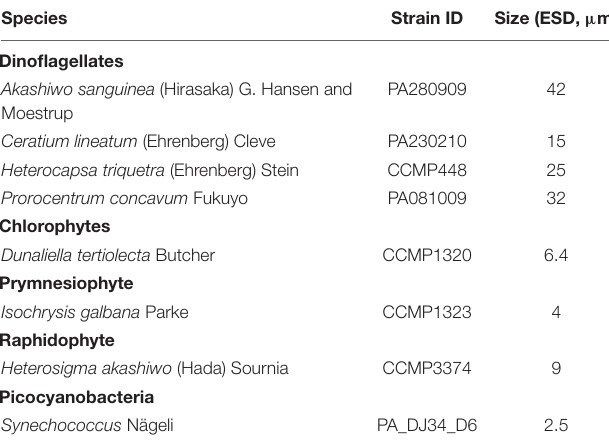
TABLE 1 | Species analyzed in this